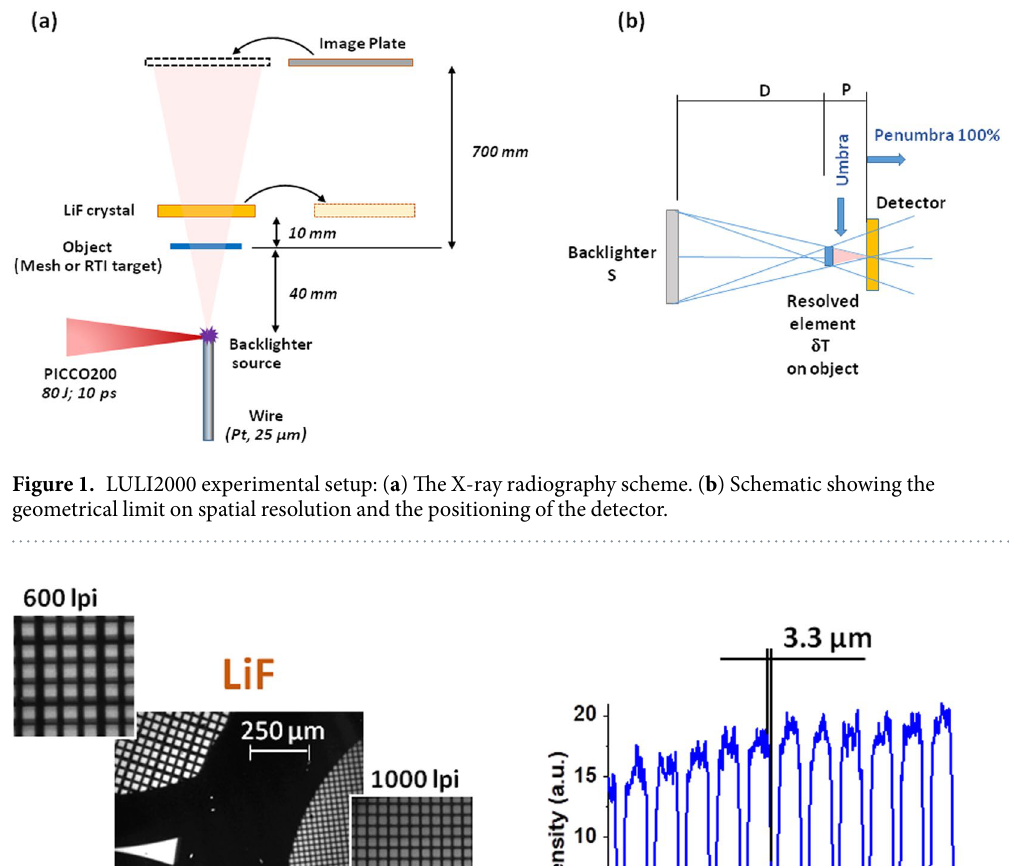
(2018) 8:16407 | DOI:10.1038/s41598-018-34717-9